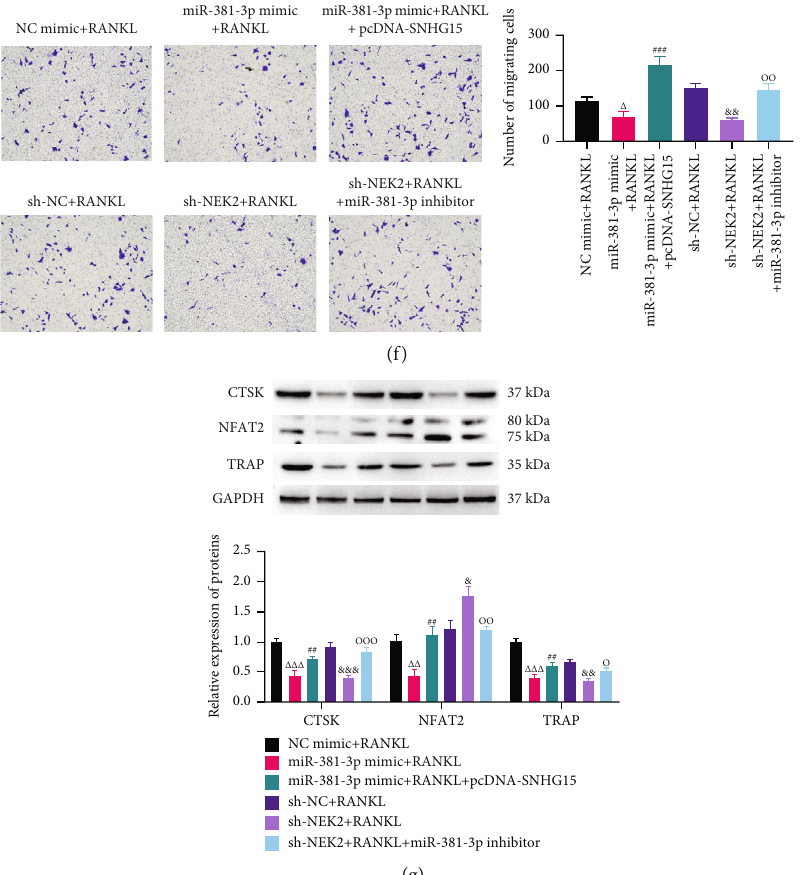
Figure 4: E ff ects of SNHG15/miR-381-3p/NEK2 axis on osteoclast di ff erentiation, proliferation, and movement of osteoclast precursors. (a) Western blot was used to detect the proteins expression of NEK2; (b) the expression of miR-381-3p was detected by RT-qPCR; (c) The mRNA expression of NEK2 was detected by RT-qPCR; (d) CCK-8 was used to detect cell proliferation rate; (e) rhodamine-labeled phalloidin staining observed the positive rate of F-actin; (f) Transwell detected cell migration; (g) Western blot was used to detect proteins expression of osteoclast markers CTSK, MMP-9, NFAT2, and TRAP; compared with sh-NC group: ∗∗∗ P < 0 : 001 ; compared with NC mimic+RANKL group: △ P < 0 : 05 , △△ P < 0 : 01 , △△△ P < 0 : 001 ; compared with miR-381-3pmimic+ RANKL group: # P < 0 : 05 , ## P < 0 : 01 ; compared with sh-NC+ RANKL group: & P < 0 : 05 , && P < 0 : 01 ; compared with sh-NEK2+RANKL group: ○ P < 0 : 05 , ○○ P < 0 : 01 , and ○○○ P < 0 : 001